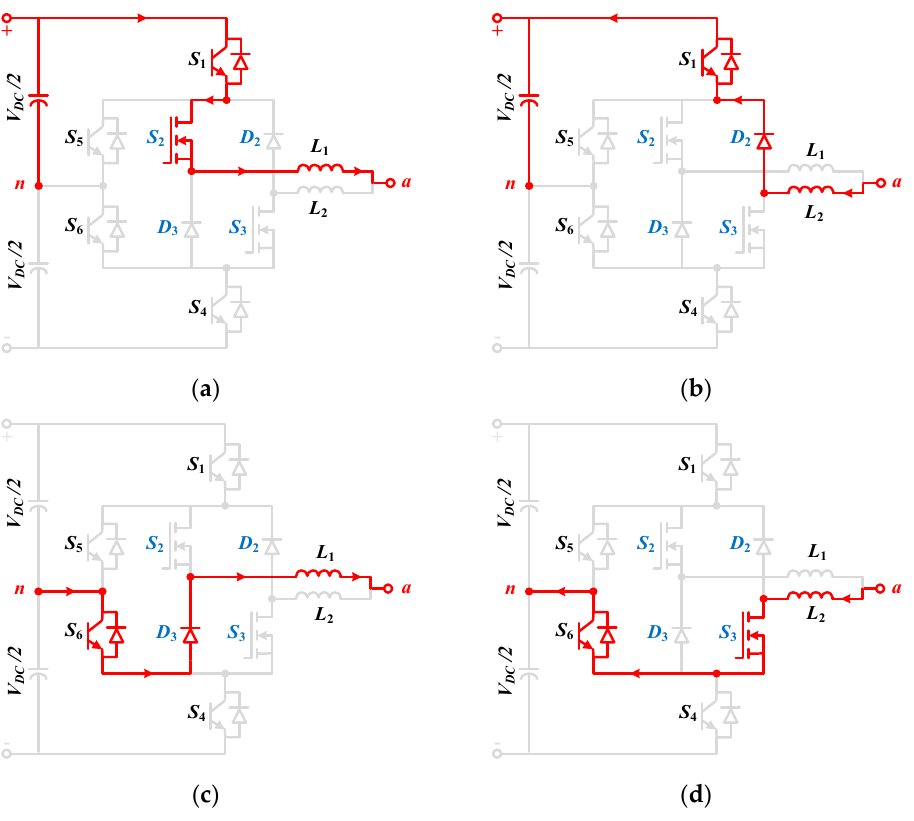
Figure 5. Switching paths of the hybrid ANPC inverter during positive half cycle: ( a ) mode 1 with i L > 0, ( b ) mode 1 with i L < 0, ( c ) mode 2 with i L > 0, and ( d ) mode 2 with i L < 0.